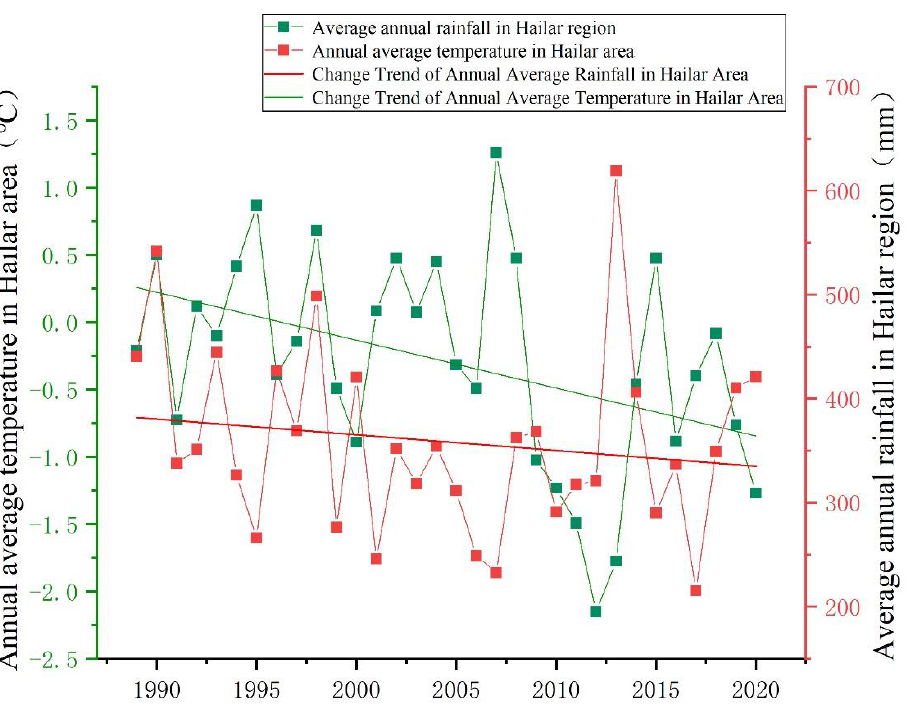
Figure 13. Trends in annual average temperature and annual rainfall in Hai La Er from 1989 to